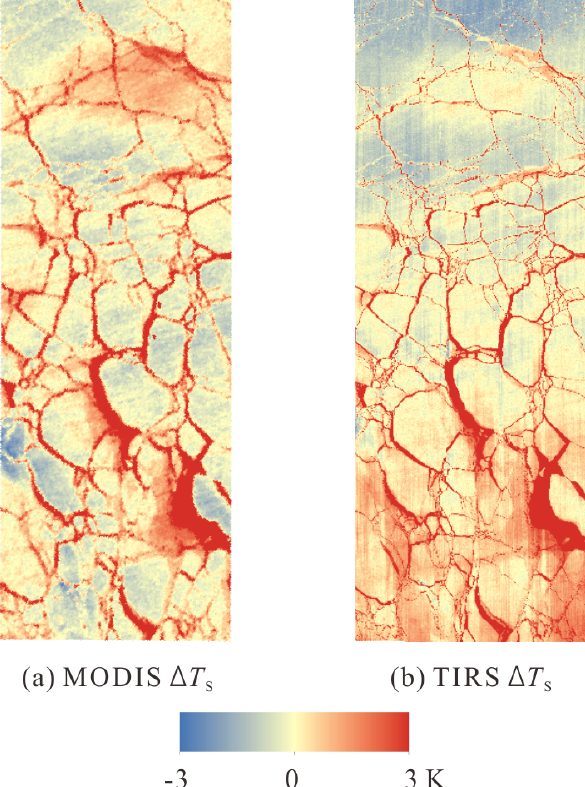
Figure 8. Local temperature anomalies from (a) MODIS and (b) Landsat-8